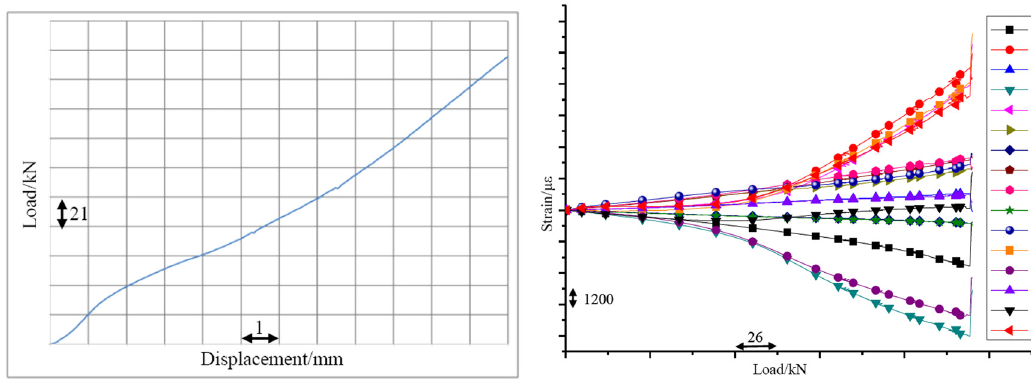
Figure 10: c2 - type test